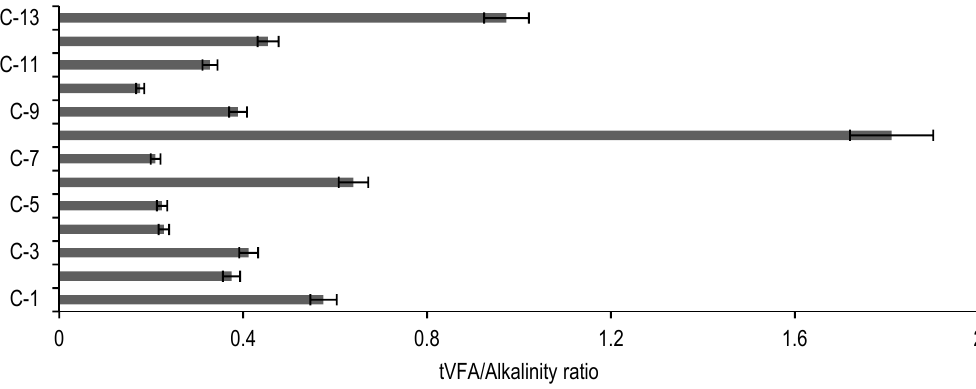
Figure 3. The tVFA/Alkalinity ratio for each combination at the end of the experimentation.